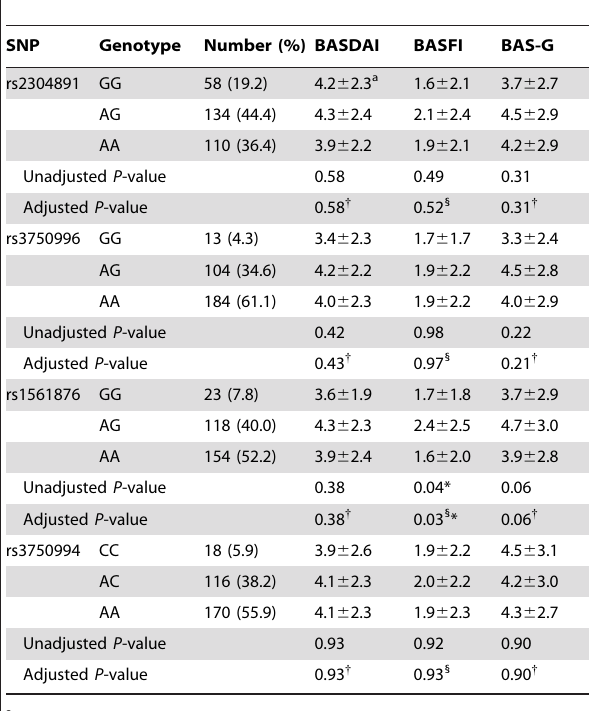
Table 2. Difference in the scores of BASDAI, BASFI, and BAS-G among HLA-B27 positive AS patients stratified by different STIM1